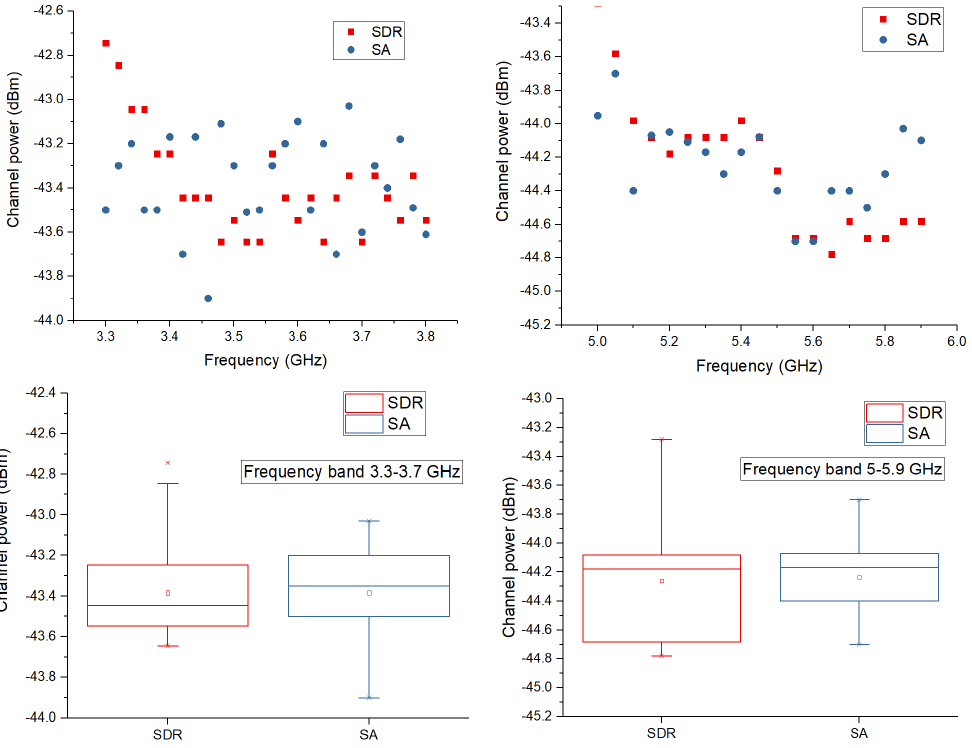
Figure 12. SDR calibration results in 3.3–3.7 GHz frequency band ( left ) and 5–5.9 GHz frequency band ( right ). Table 2. Comparative analysis of the measurement